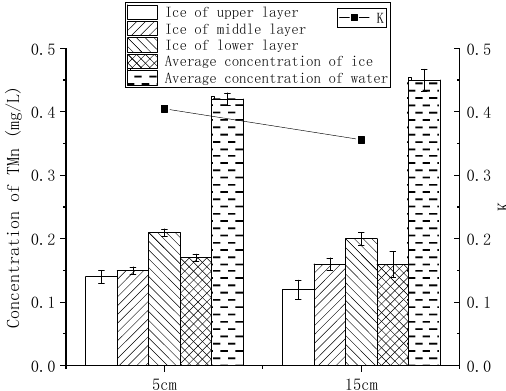
Figure 2. Distribution of total manganese (TMn) in Ice-water System During Natural Icing.